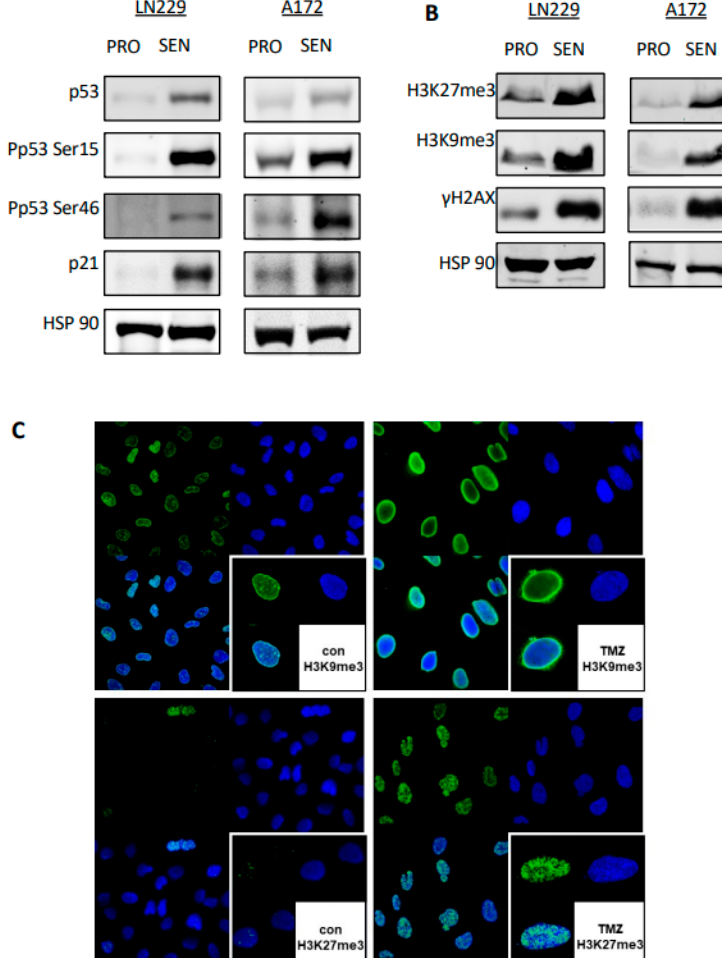
Figure 6. Senescent cells show a sustained DDR and senescence-associated histone methylation. ( A ) Expression levels of p53, phosphorylated p53ser15 and ser46, and p21 in proliferating (PRO) and TMZ-induced senescent LN229 and A172 cells. ( B ) Levels of marker of senescence in proliferating and TMZ-induced senescent LN229 and A172 cells. ( C ) Immunohistochemistry of nontreated and TMZ-treated (50 µM, 144 h post exposure) LN229 cells with senescence-associated histone methylation marker H3K9me3 and H3K27me3. Green fluorescence: histone marker; blue: nuclear staining with topo3; white: merged staining. Right bottom corner: field with higher magnification.